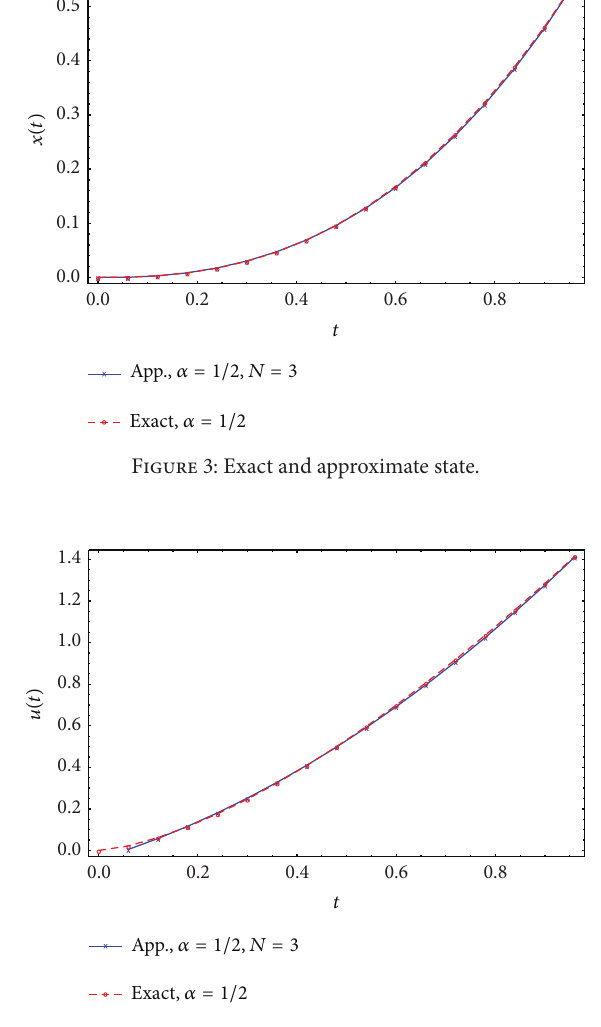
Figure 4: Exact and approximate control.